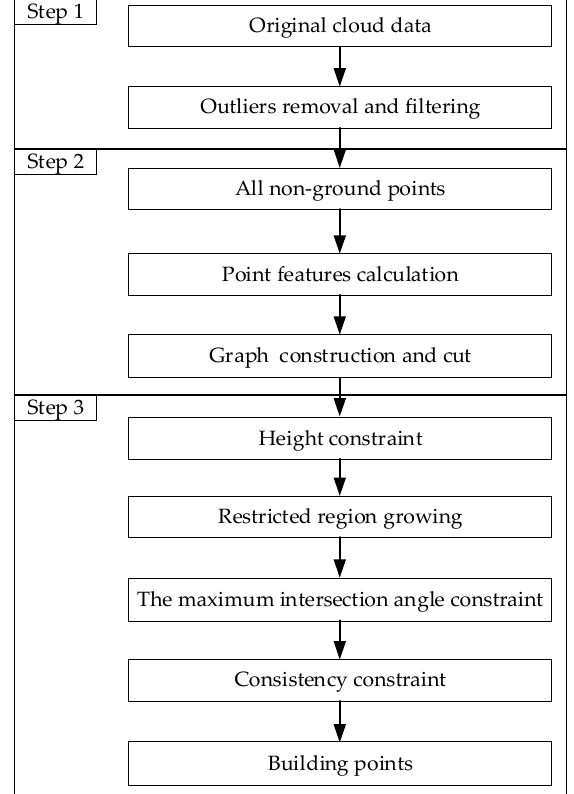
Figure 1. Algorithm flowchart.